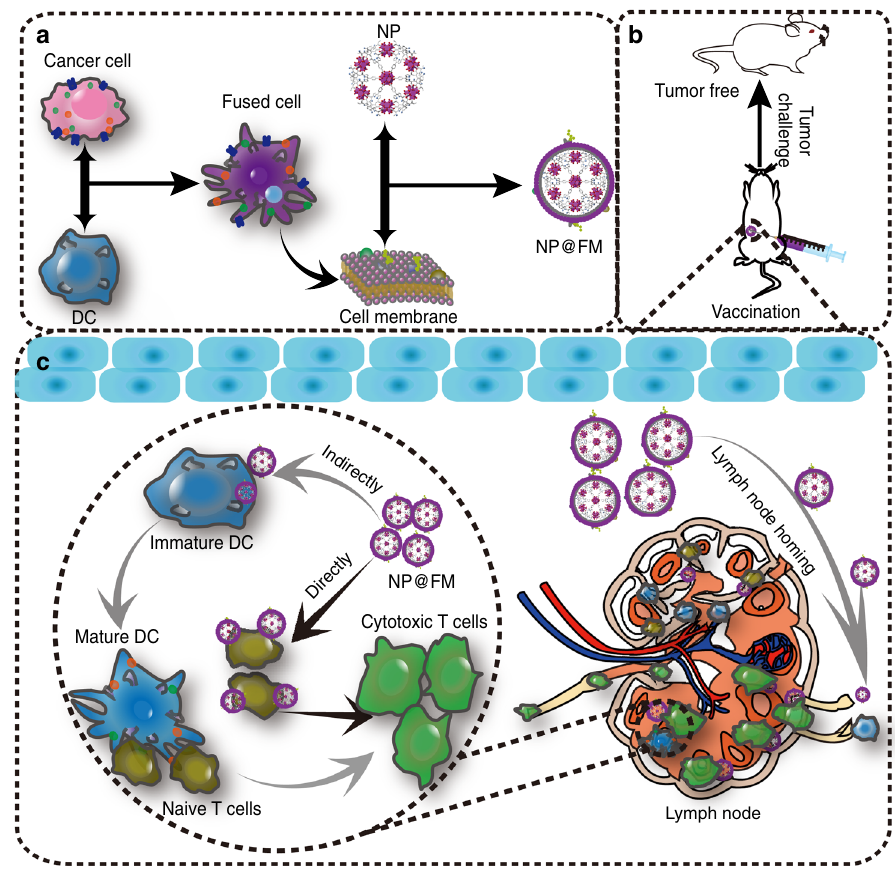
Fig. 1 Schematic illustration of MOF@FM for tumor prevention. a Preparation of MOF@FM. b Vaccination of MOF@FM for tumor prevention. c Mechanisms of MOF@FM inducing immune